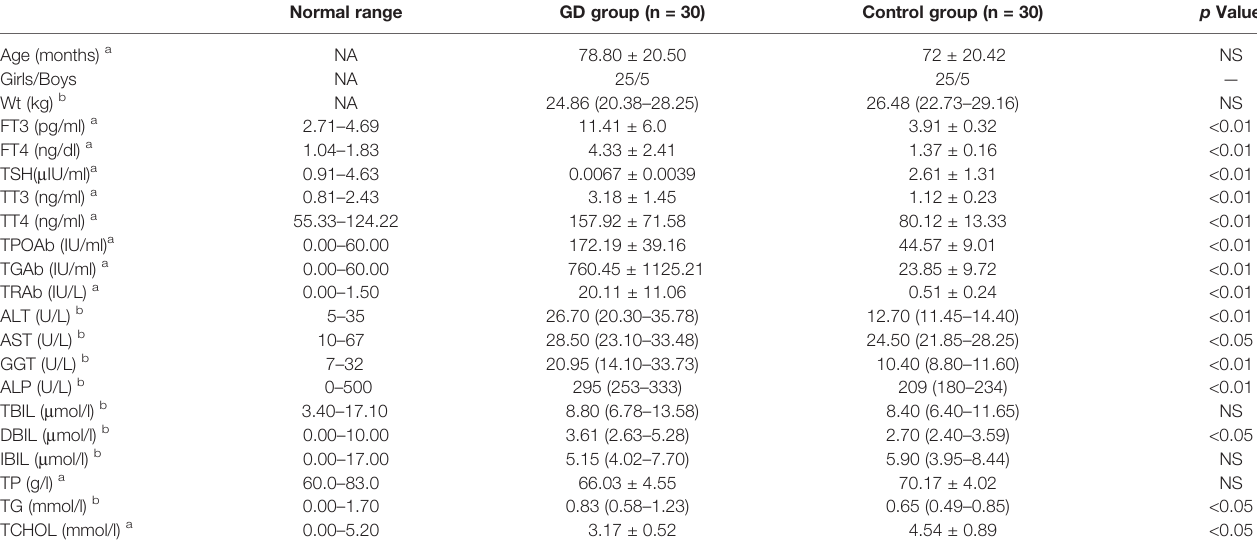
TABLE 1 | Clinical characteristics of the GD and control